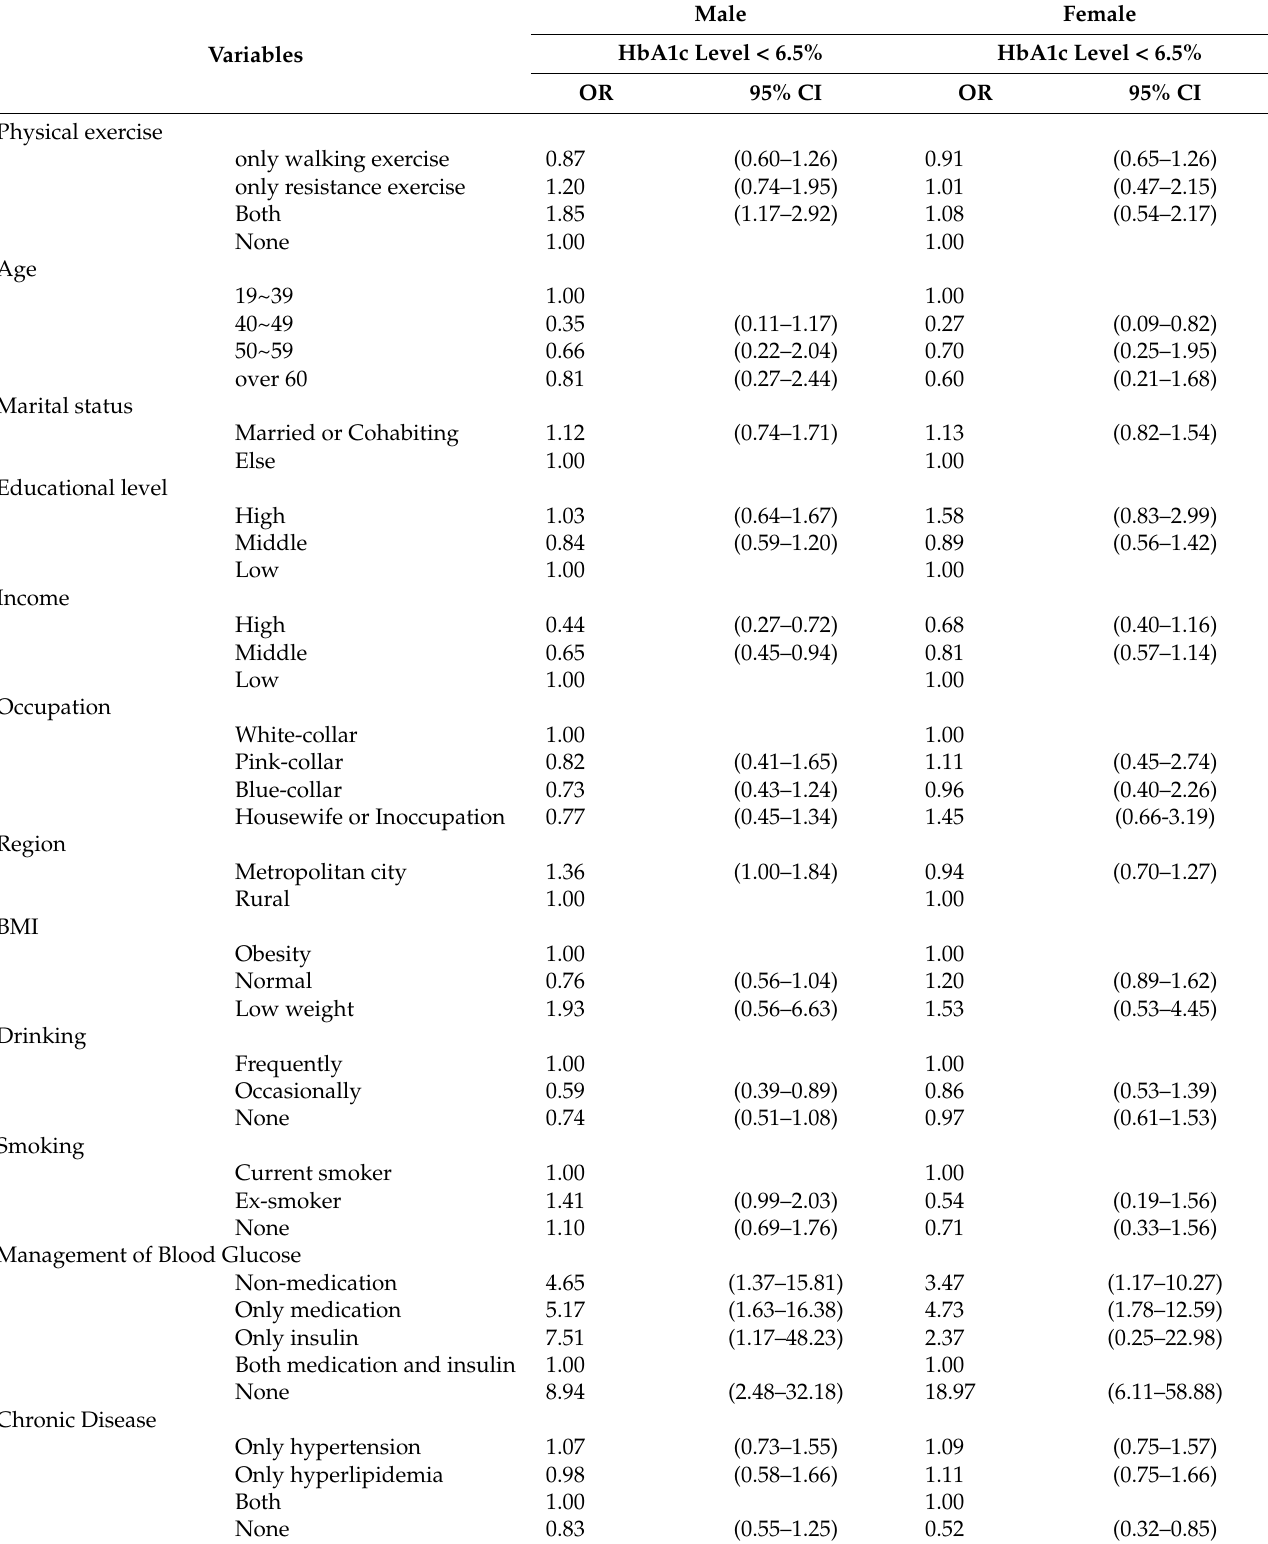
Table 2. Results of multiple regression analysis to investigate the association between physical exercise and HbA1c